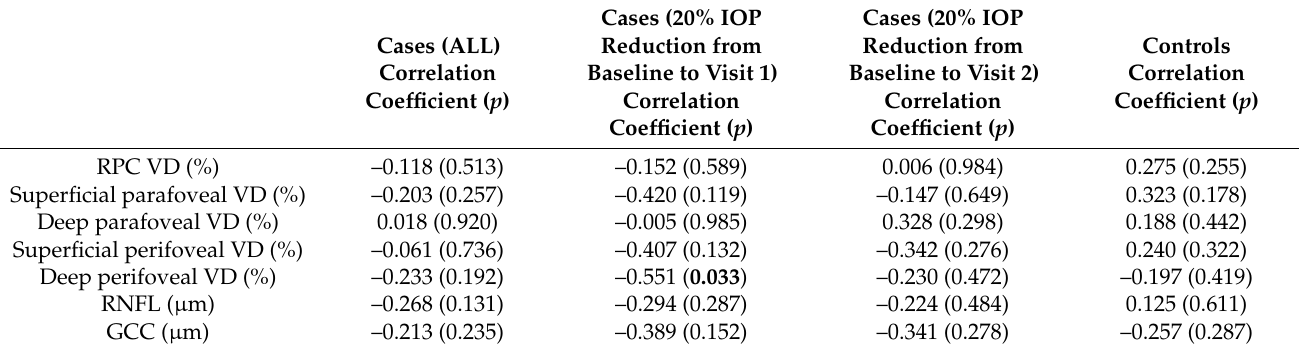
Table 3. Correlation of baseline intraocular pressure with optical coherence tomography angiogra- phy parameters.